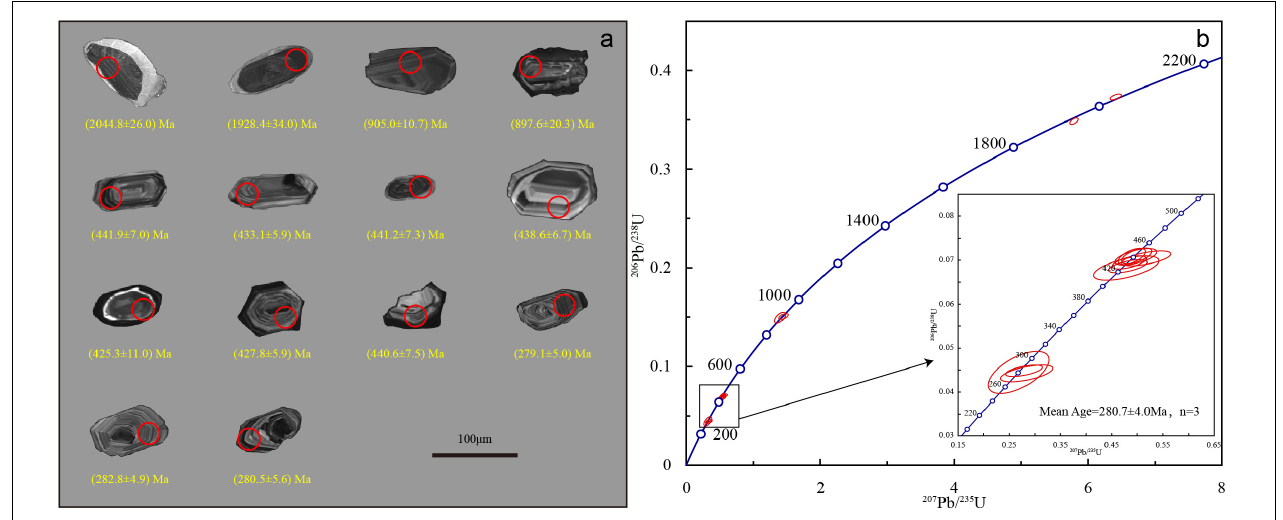
FIGURE 3 | Cathodoluminescence (CL) images (a) and U-Pb concordia diagrams (b) for Gubaoquan dolerite dykes.